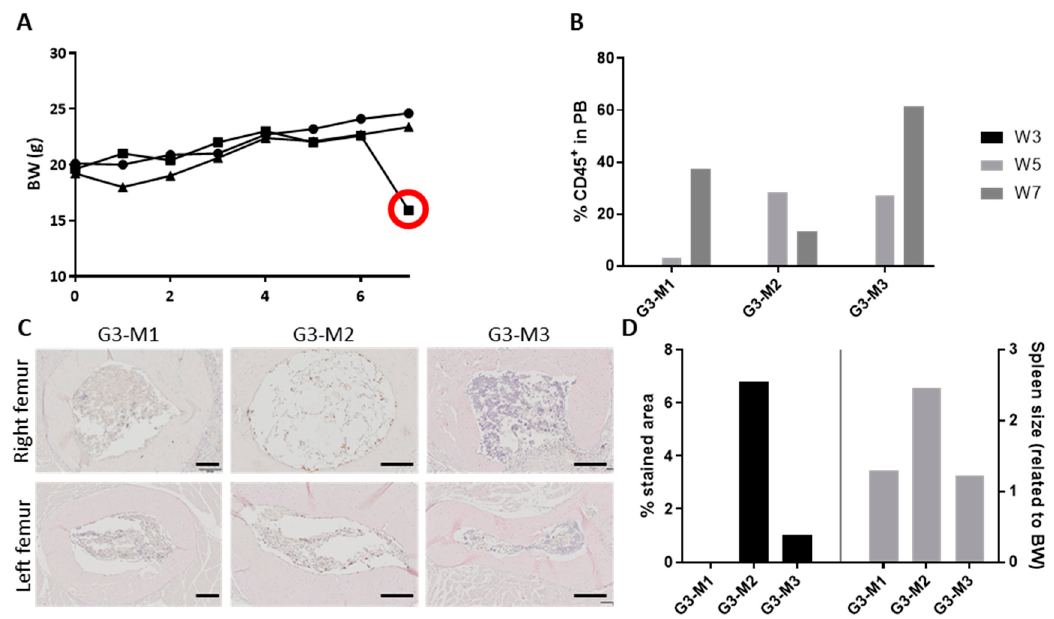
Figure 4. Excessive engraftment of CD34 + cells might cause graft vs. host disease (GvHD)-like symptoms. One of the mice showed signs of GvHD. First, a weight loss of 20% in less than a week ( A ). In addition, a decrease in the number of hCD45 + in peripheral blood ( B ) and reduced haematopoietic tissue in the BM, as compared with other mice ( C ). The spleen size was enlarged, and more hCD45 + infiltration occurred, which could have affected the spleen tissue ( D ). Scale bars: 200 µm. BW: body weight, G3-M1: group 3, mouse